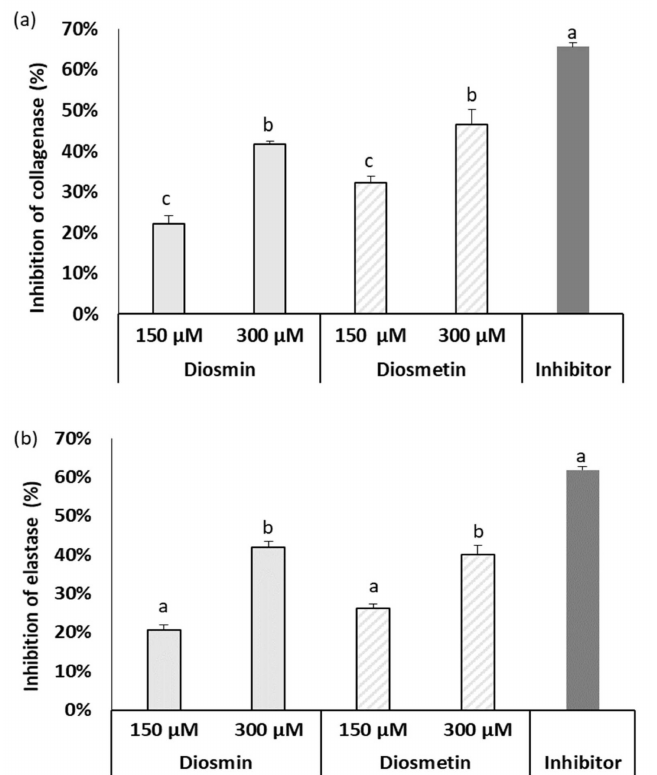
Figure 4. Effect of diosmin or diosmetin on collagenase ( a ) and elastase ( b ) activity. The data are means ± SD ( n = 3). The lowercase letters, a, b, c, denote significant differences between objects; values followed by the same letter are not significantly different according to Tukey’s test ( p ≤ 0.05). Succinyl-alanyl-alanyl-prolyl-valine chloromethylketone-SPCK (20 mM) and 1,10-phenanthroline (10 mM) were used as inhibitors of elastase and collagenase, respectively.